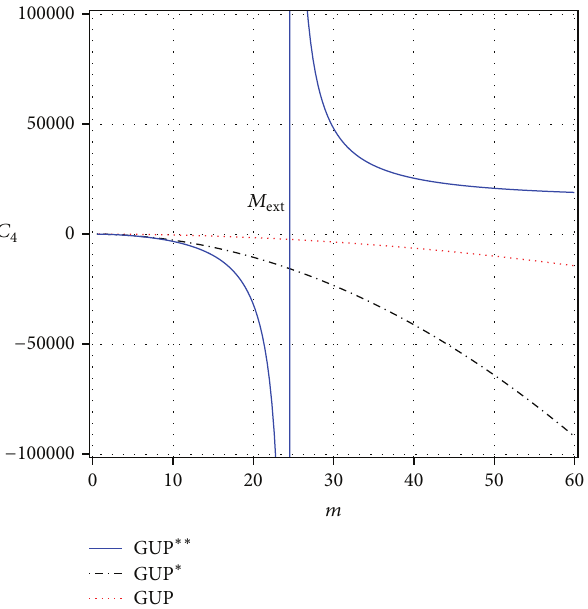
Figure 8: Black hole heat capacity as a function of mass for 𝑑 = 4 with different types of GUPs.